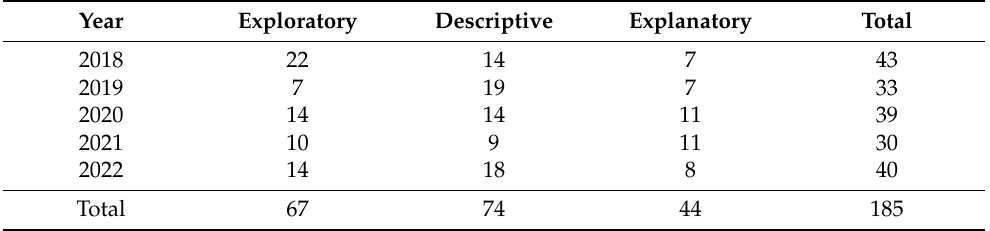
Table 6. Research